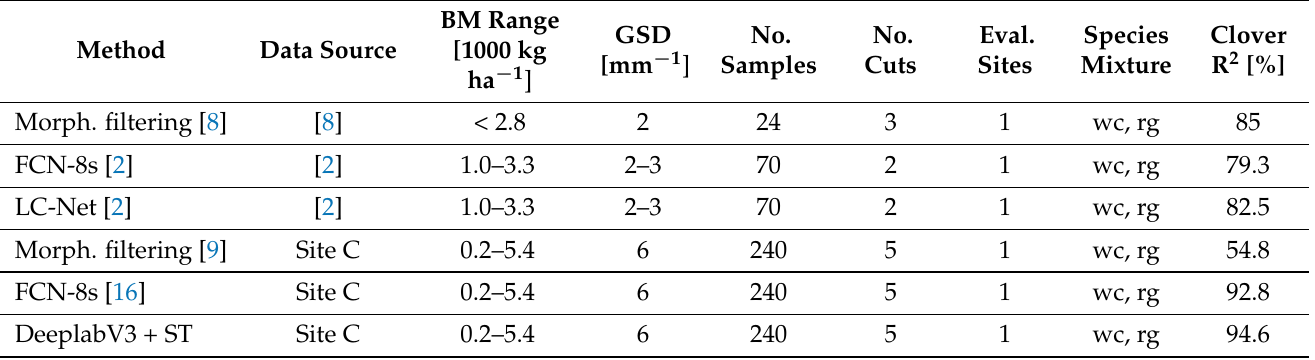
Table 6. Comparison with previously published results on image based prediction of biomass clover fractions. For fair comparison, only mixtures with similar species are compared. Due to the scarcity of published results on ryegrass, white clover, and red clover mixtures, only mixtures of ryegrass and white clover (site C) were included in this comparison. When a data source is referenced, the corresponding R 2 is reprinted from the data source. wc and rg is white clover and ryegrass, respectively. BM is biomass. GSD is ground sampling